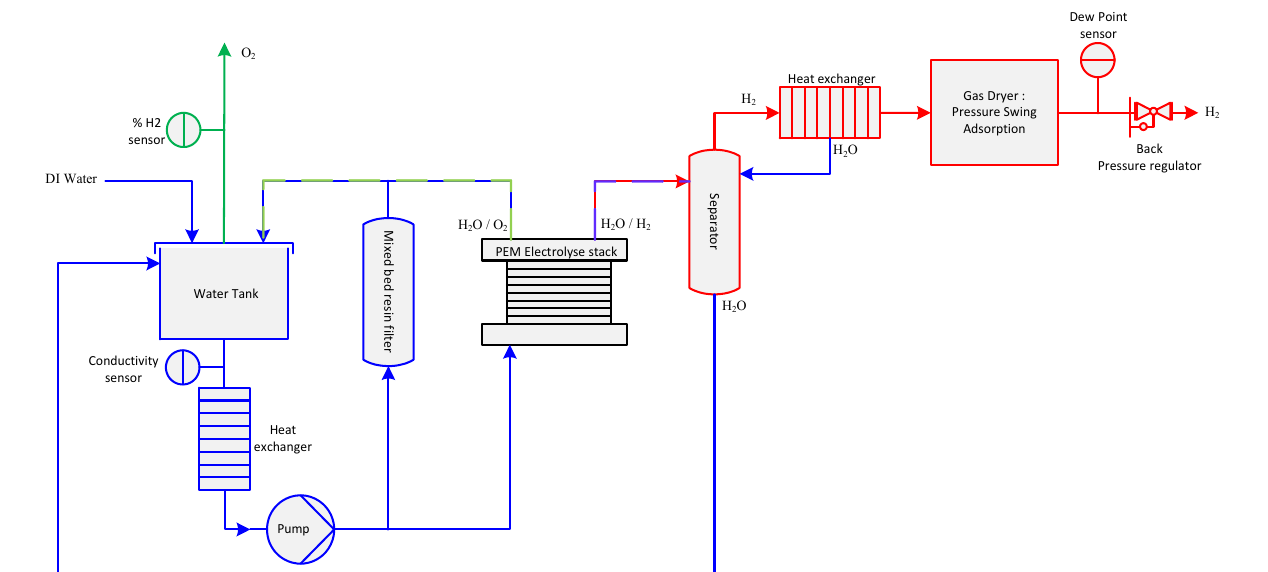
Figure 3. Simplified scheme of electrolyser device including main components.